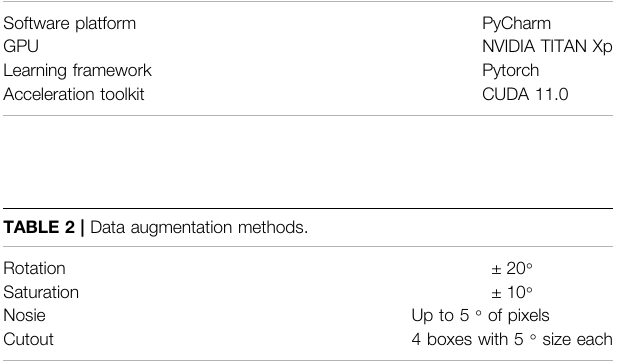
TABLE 4 | Different performances of loss function.